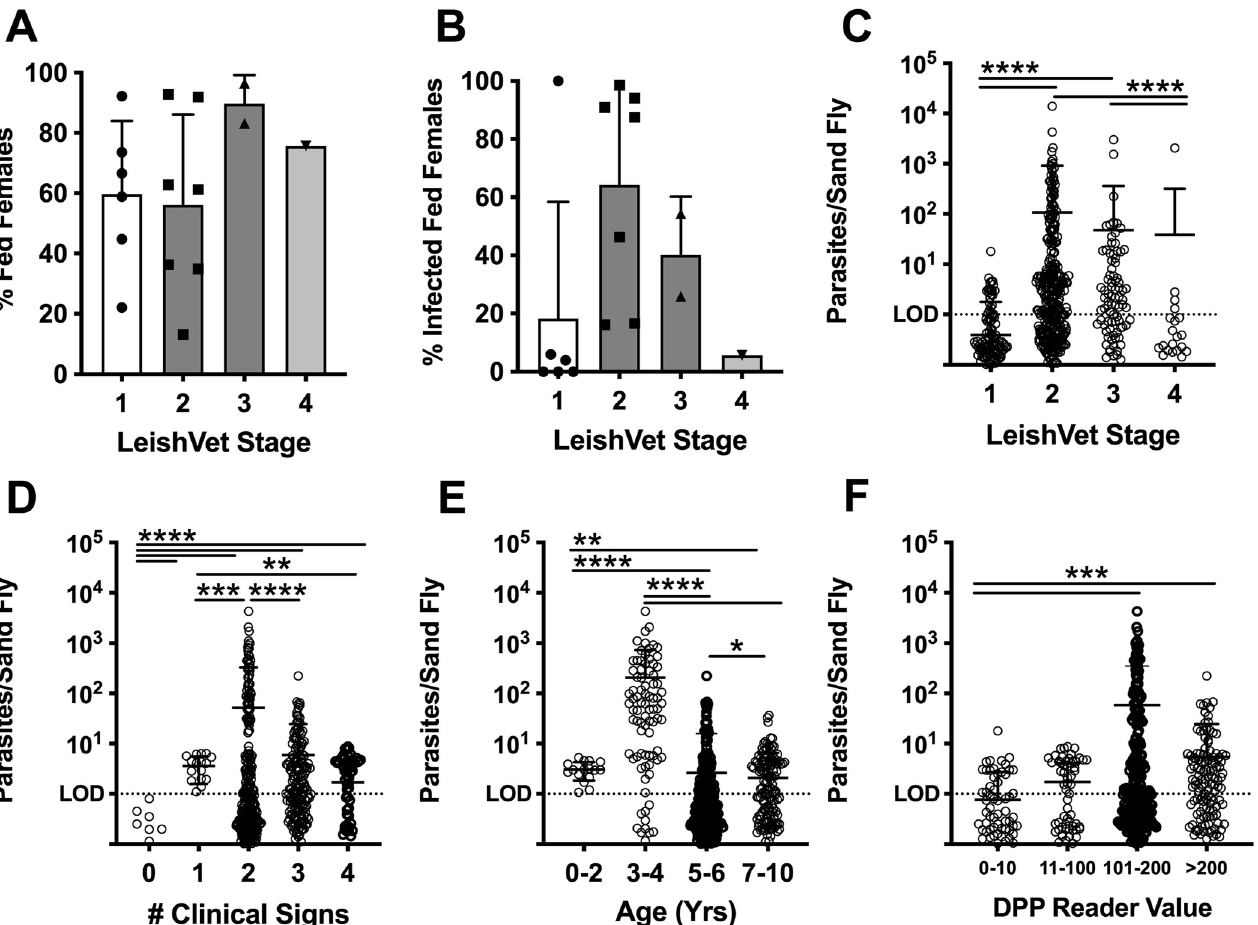
Fig 3. Higher parasite uptake among sand flies fed on dogs with moderate disease. (A) Frequency of sand flies containing a blood meal and (B) frequency of blood meal containing sand flies containing > 1 calculated parasite after xenodiagnosis on dogs at indicated LeishVet clinical stages. (C-F) Calculated number of parasites per individual sand fly after xenodiagnosis on dogs with indicated LeishVet clinical stage (C), number of VL clinical signs (D), age range (E), or DPP serological value (F). Kruskal Wallis ANOVA with Dunn’s post-test. �� p < 0.01; ��� p < 0.001; ���� p < 0.0001.